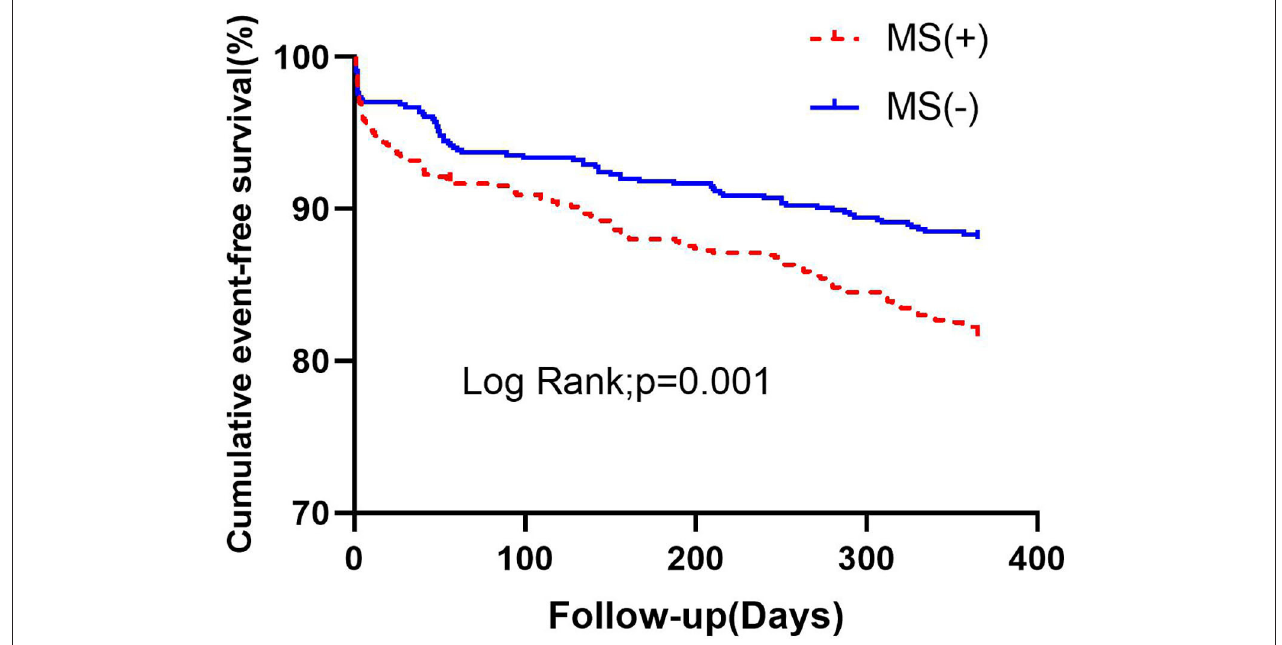
FIGURE 1 | Kaplan-Meier survival analysis of cumulative event-free survival curves within 1 year according to MS. MS, metabolic syndrome.